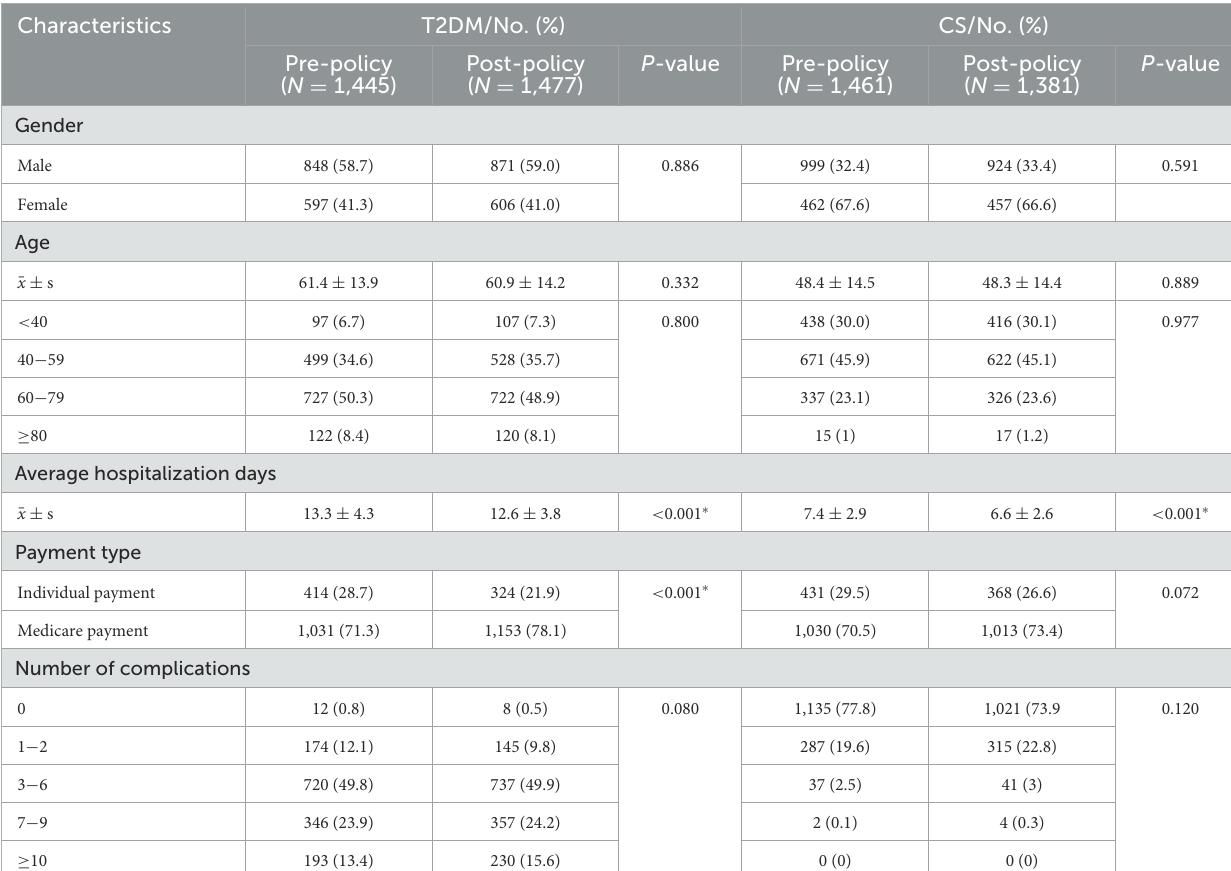
TABLE 3 Demographic and clinical characteristics of patients included before and after the reform.